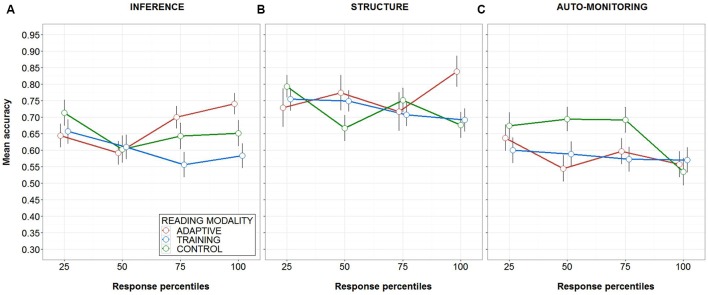
Mean accuracy (with error bars plotting the standard error of the mean) as a function of meta-cognitive skill, response percentile and reading modality. (A–C) correspond the results for inference making, text structure knowledge and comprehension monitoring, respectively.